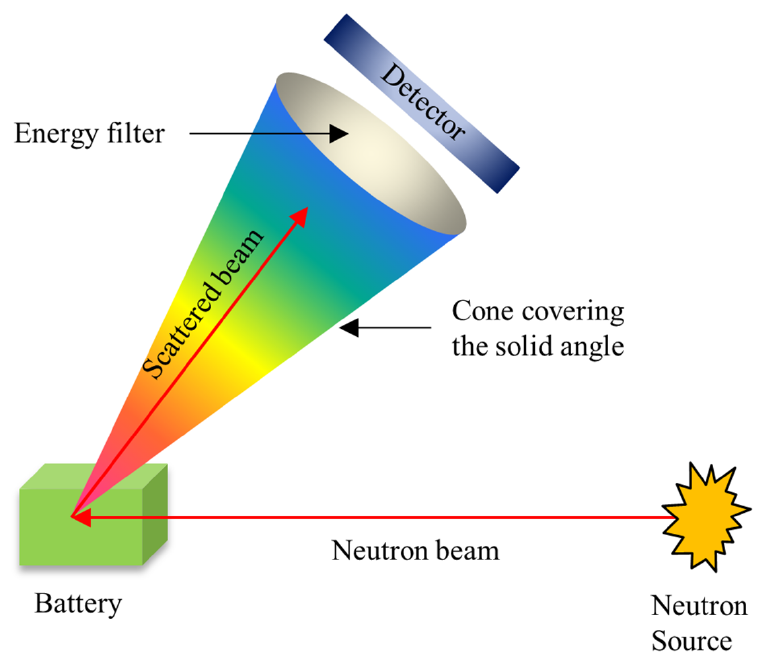
Figure 13. Scheme of experimental set-up for in situ / Operando INS (adapted with permission from Ref. [86]. 2006 Mineralogical Society of America).